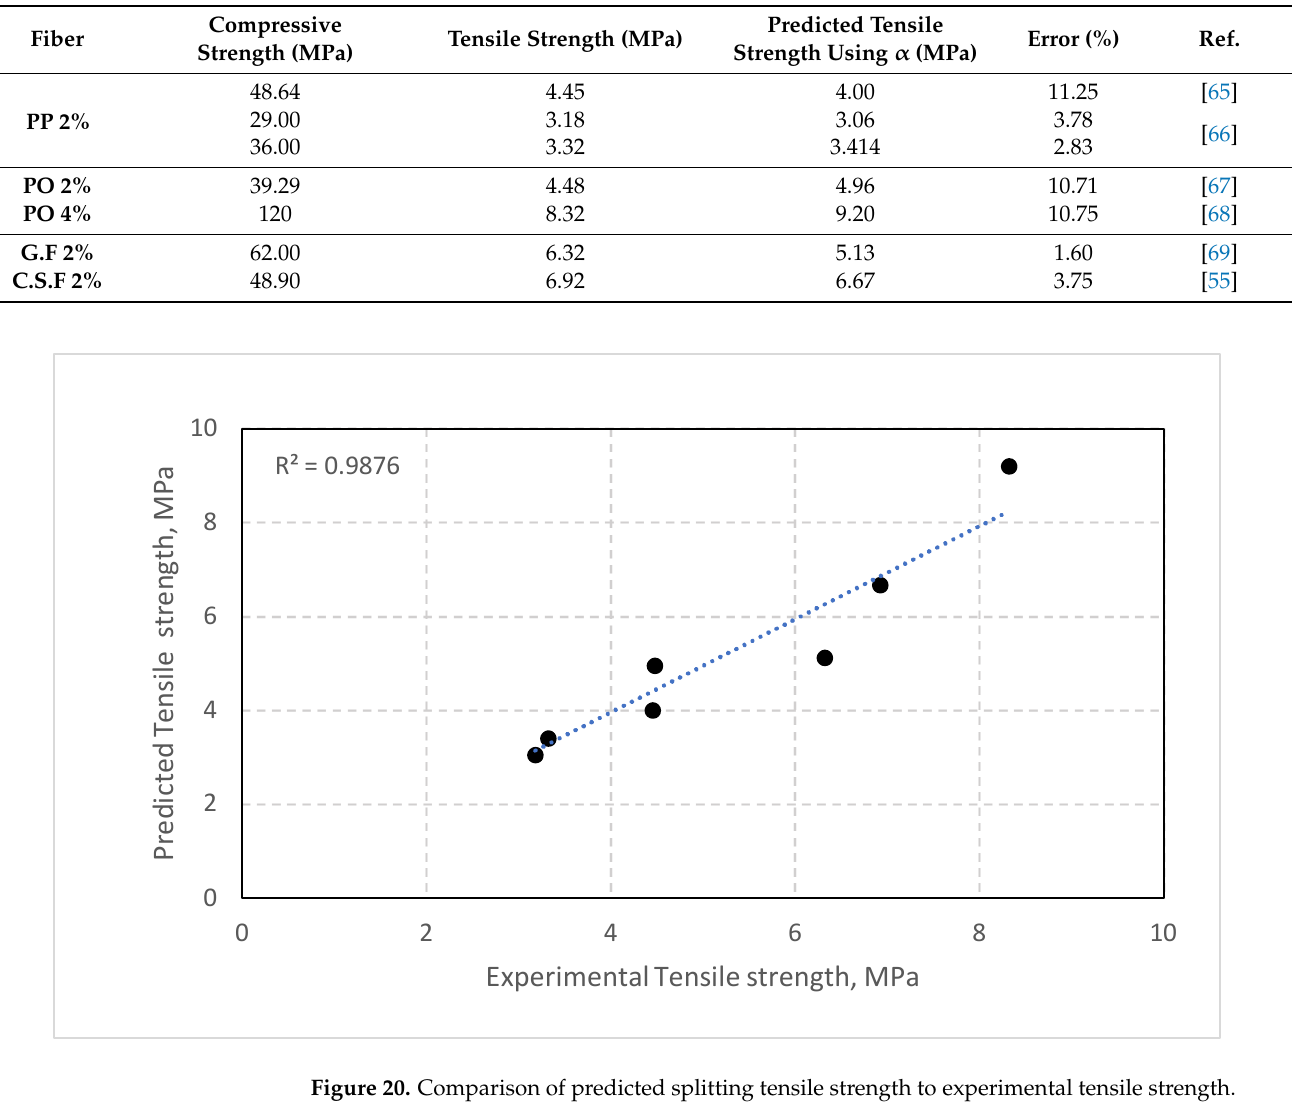
Table 8. Verification of proposed α values using external data set.